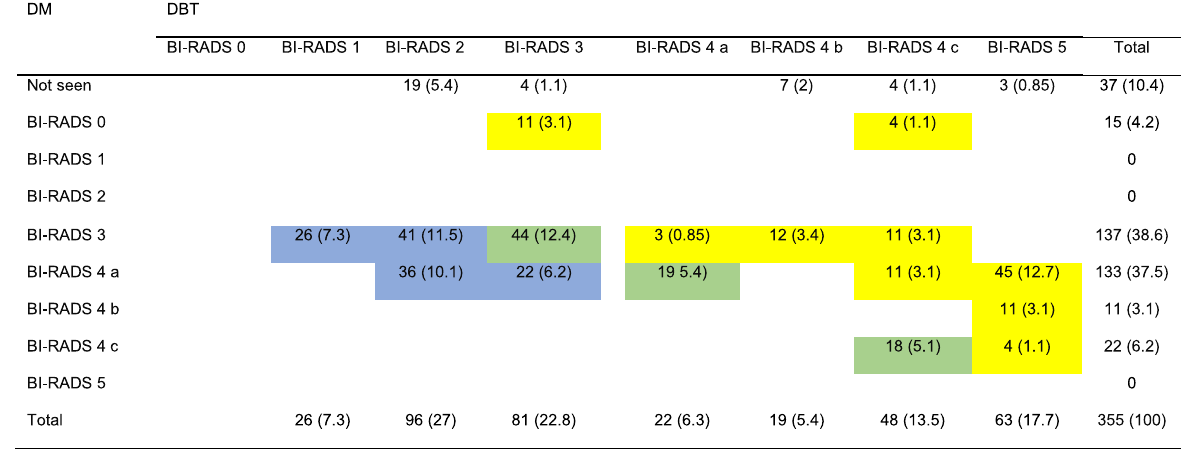
Table 4 Change in individual breast lesion grading on account of DBT, compared to DM